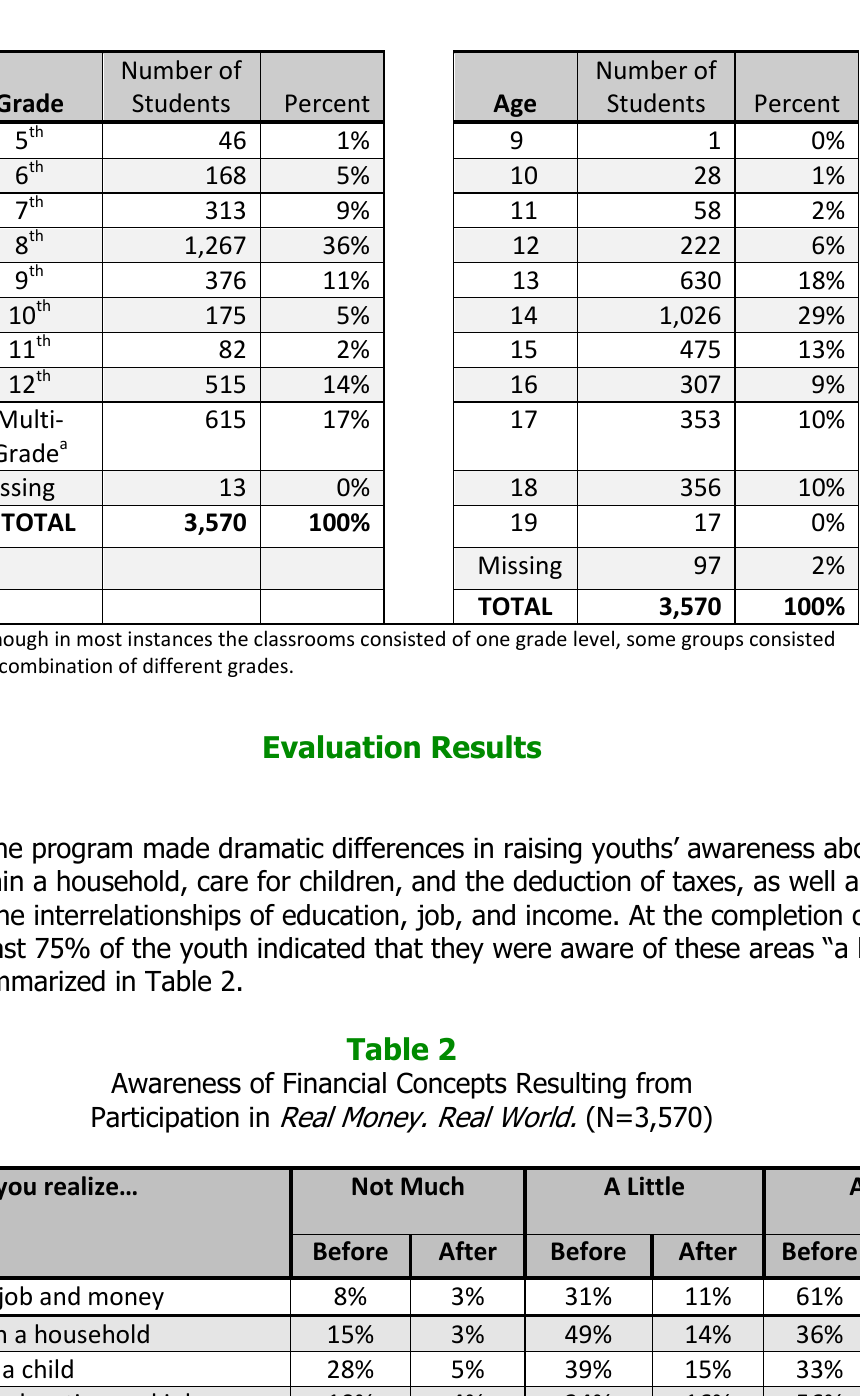
Participant Characteristics